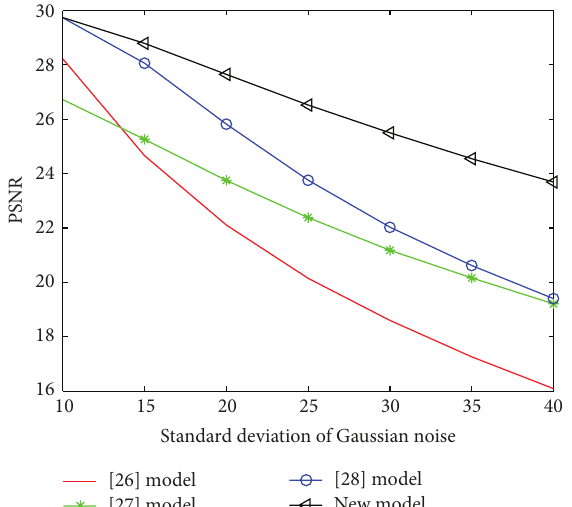
Figure 7: PSNR (dB) graph of [26–28] and new algorithms for various Gaussian noises for Miss America video